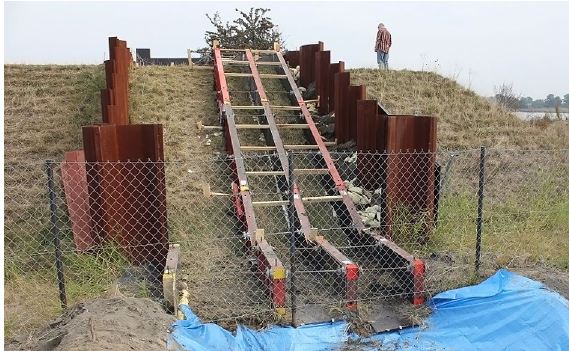
Fig. 5. Basic experimental set-up of the Gdansk flume